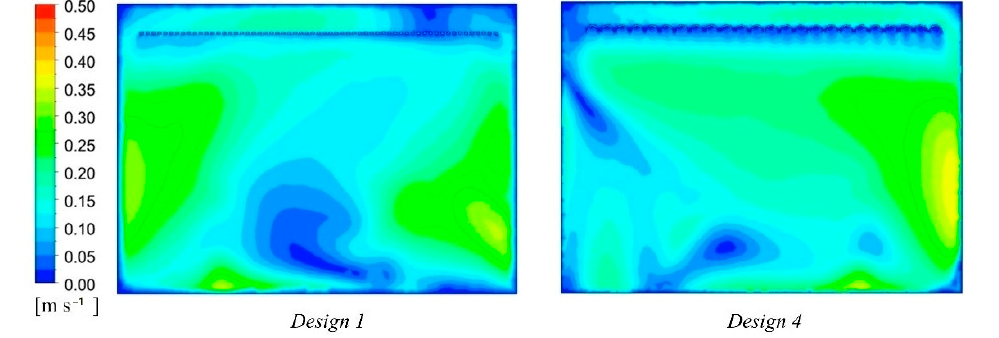
( b ) Figure 8. Comparison of different curvature radii ( a ), cooling capacity curves [27,32] ( b ), and ther- mal performances under a cooling load of 1405.02 W. 4.3.3. Void Distance Figures 9 and 10 illustrate the effect of voids between adjacent panels or panel seg- ments. Eight different distances were compared, varying from 0 m to 0.3 m, with L = 0.06 m and r = 0.06 m. A solid panel without an opening (Design 10) results in the same nomi- nal cooling capacity as the CRCP proposed by Shin et al. When d is expanded from 0 m to 0.03 m, the nominal cooling capacity increases significantly by 33% from 101.27 W/m 2 to 134.69 W/m 2 , and the h r and h c are improved by 6.4% and 92.9%, respectively. Including an opening between panels or panel segments can effectively increase convection heat